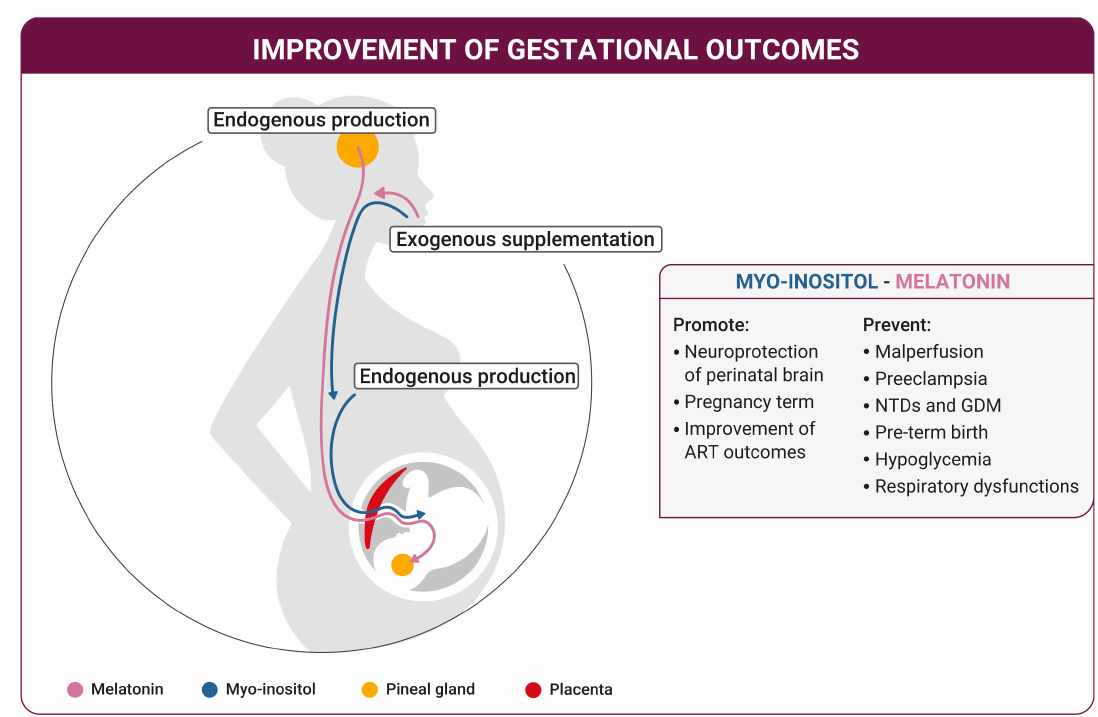
Figure 2. Improvement of gestational outcomes. A dietary supplementation of myo-inositol and melatonin, along with the endogenous production, optimize their circulating levels in the female body improving the gestational outcomes. There is a molecular hand-over of these molecules from the mother to the fetus through the placenta. The melatonin production from the pineal gland of the mother stimulates the pineal gland of the fetus until it becomes able to produce its own melatonin and to self-sustain its own circadian rhythm. Myo-inositol and melatonin promote neuroprotection of the fetus brain, favor the physiological pregnancy term, and improve the ART outcomes, as well as prevent the occurrence of pathological conditions during